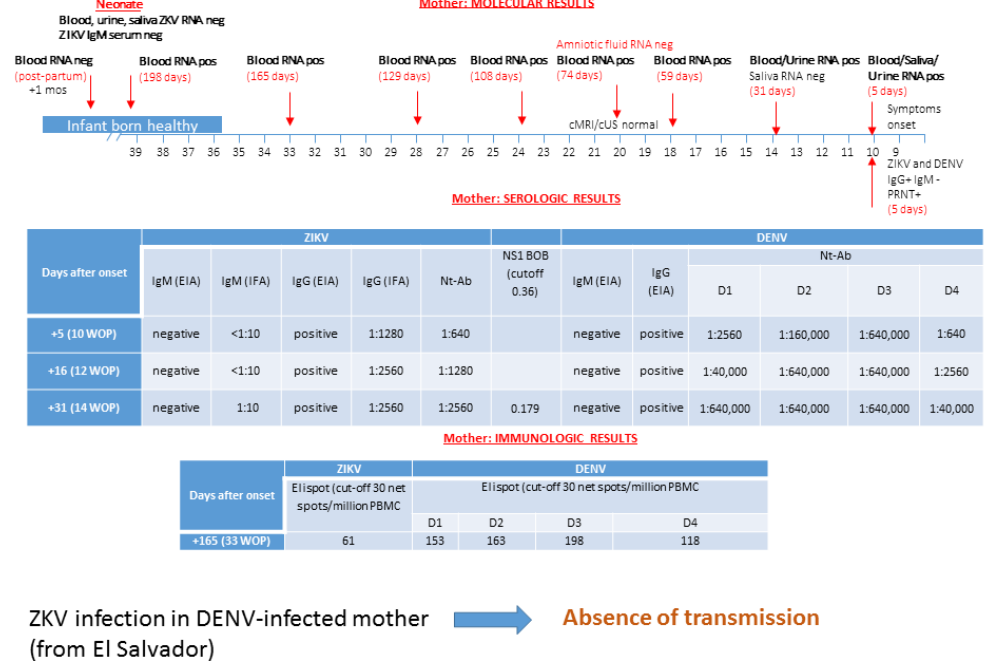
Figure 1. Data on molecular, serological, and immunological diagnosis for Zika virus (ZIKV) and Dengue virus (DENV) infection in a pregnant woman from El Salvador are shown. ZIKV infection in the DENV-infected mother was documented and transmission was not reported. cMRI/cUS: cerebral magnetic resonance imaging/cerebral ultrasonography; PRNT: plaque reduction neutralization test; WOP: week of pregnancy; EIA: enzyme immunoassay; IFA: immunofluorescence assay; Nt-Ab; neutralizing antibodies. In the box of molecular diagnosis, black numbers specify the week of pregnancy, while red numbers in brackets indicate the exact day of gestation. The blockade-of-binding (BOB) assay result is expressed as the ratio of inhibition, while the ELISpot assay is measured as net spots/million PBMC. IgG and IgM antibodies against CHKV were negative. On the contrary, ZIKV RNA was simultaneously positive in plasma, urine, and saliva. Sequencing of PCR amplicons showed identity to Central American epidemic strains of ZIKV. DENV RNA was negative in the three maternal samples tested in the